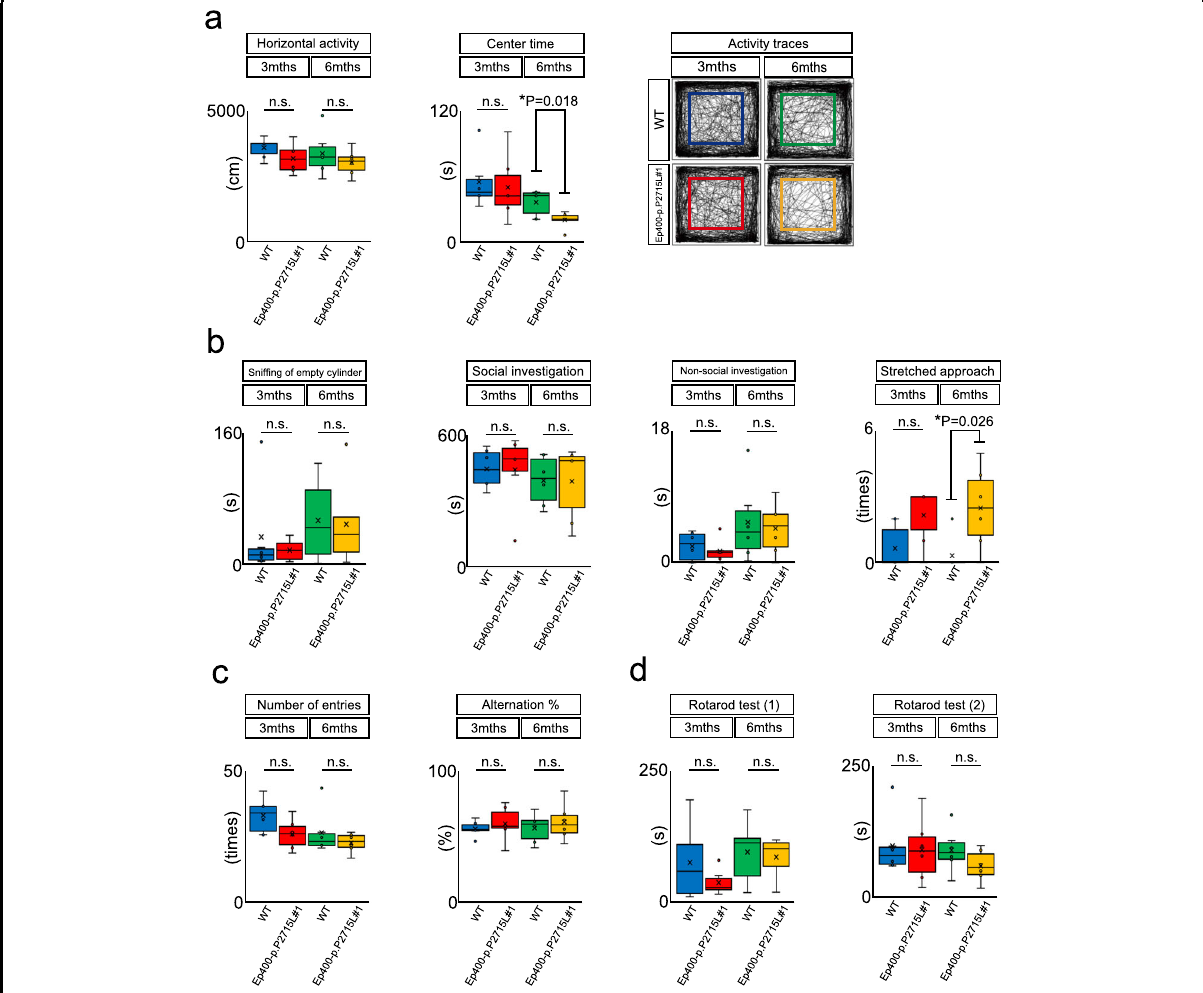
Fig. 3 Neurobehavioural screening battery in Ep400 knock-in mice. Ep400-p.P2715L#1 mice and their WT littermates were examined using behavioural tests (p.P2715L#1 mice: n = 6, WT: n = 6). a Open- fi eld test. Horizontal activity and centre time were measured, and activity traces are shown. The coloured squares represent the centre areas. b Social interaction test. Various social interaction behaviours were measured and compared. c Y-maze test. The number of entries and the percentage of alternations were measured and compared. d Rotarod test. Time spent on the rotarod before falling was measured and